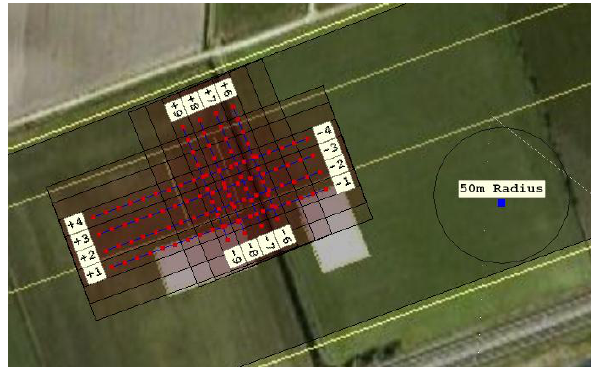
Figure 4. Flight Plan